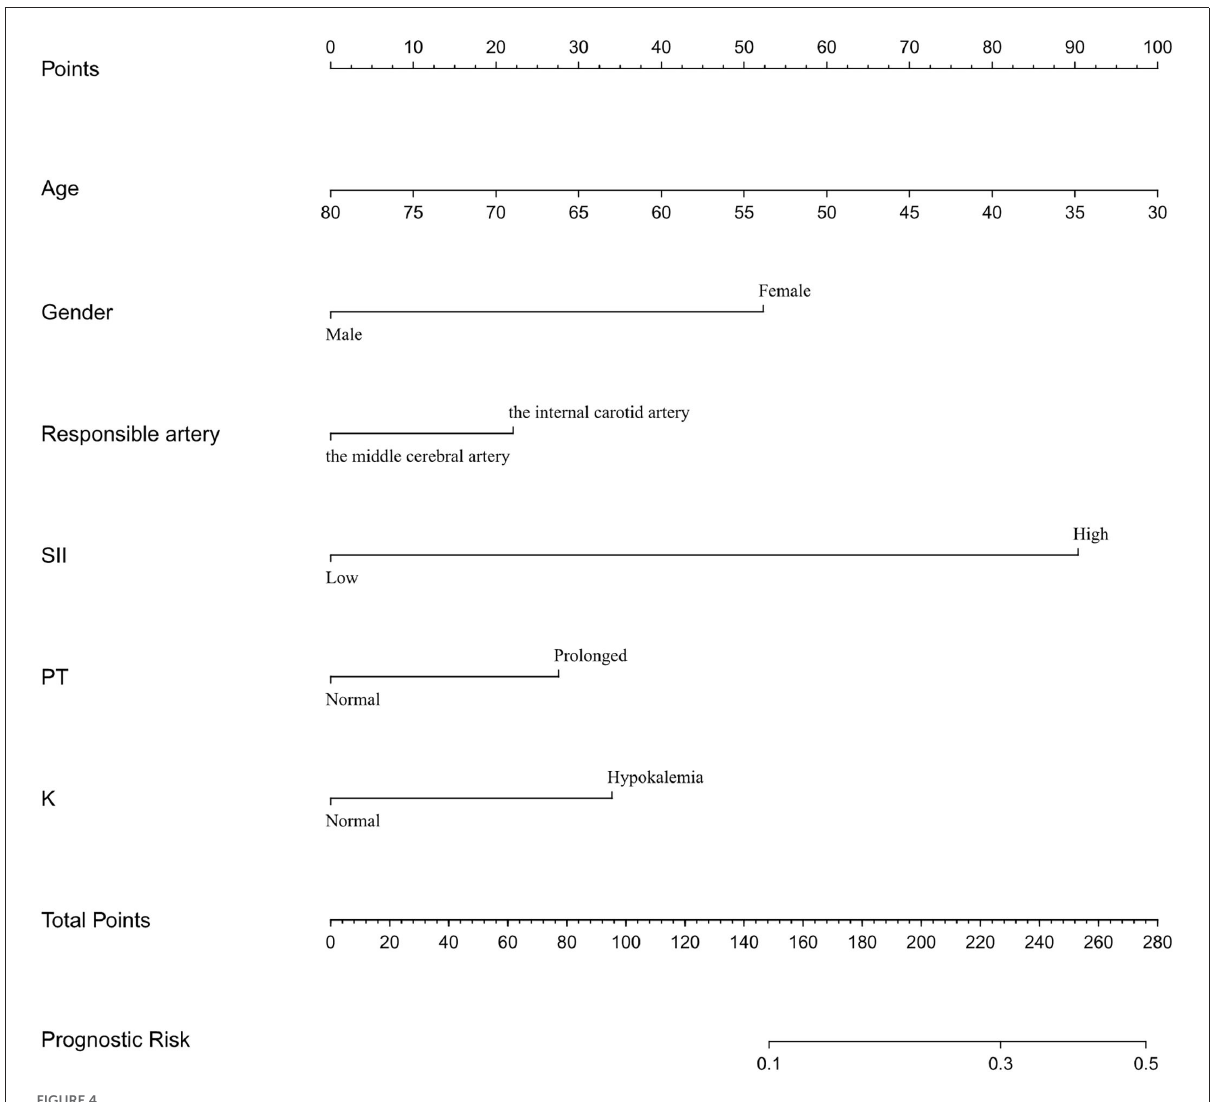
FIGURE4 Nomogram of clinical